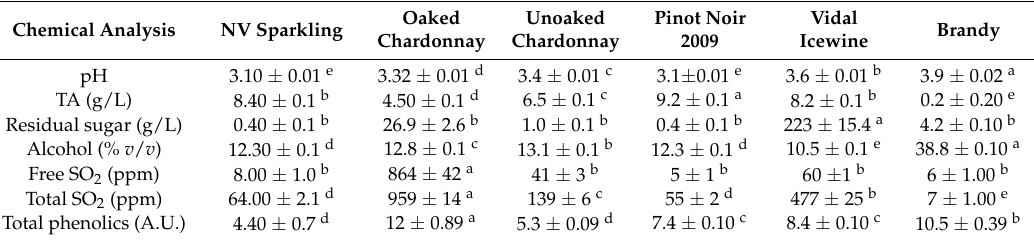
Table 3. Chemical analyses of the wines used for dosage prior to sugar addition.